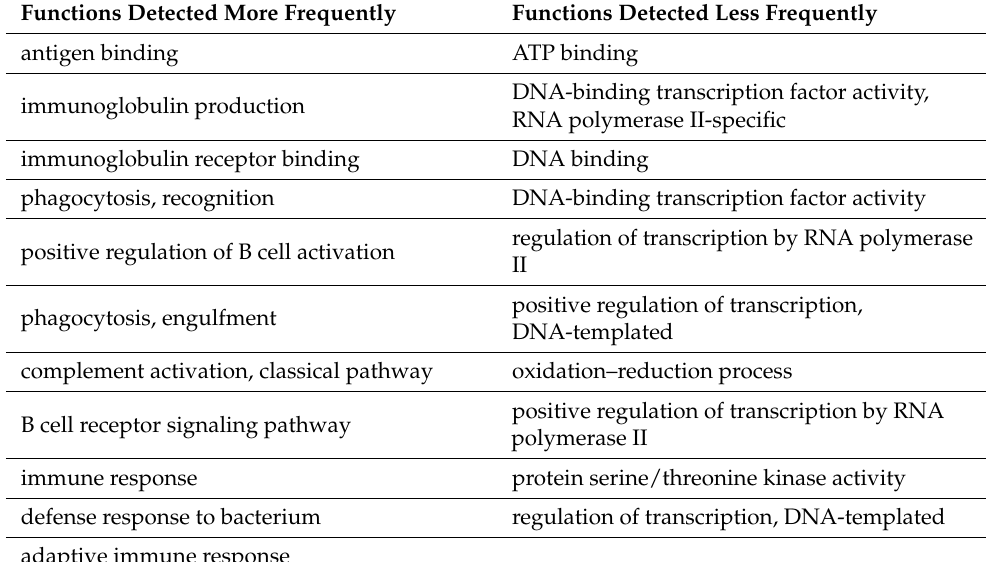
Table 2. Functions of proteins that began to be detected more/less frequently according to neXtProt over the past five